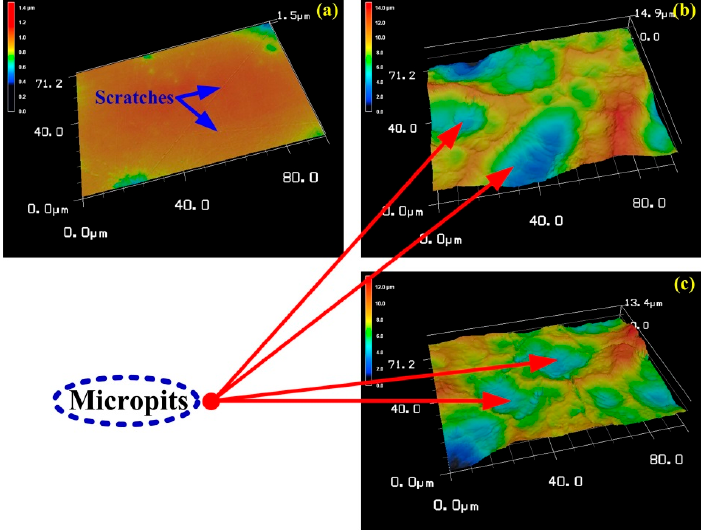
Figure 4. LSM images of different Ti samples: ( a ) P-Ti, ( b ) M-Ti, and ( c ) MN-Ti.